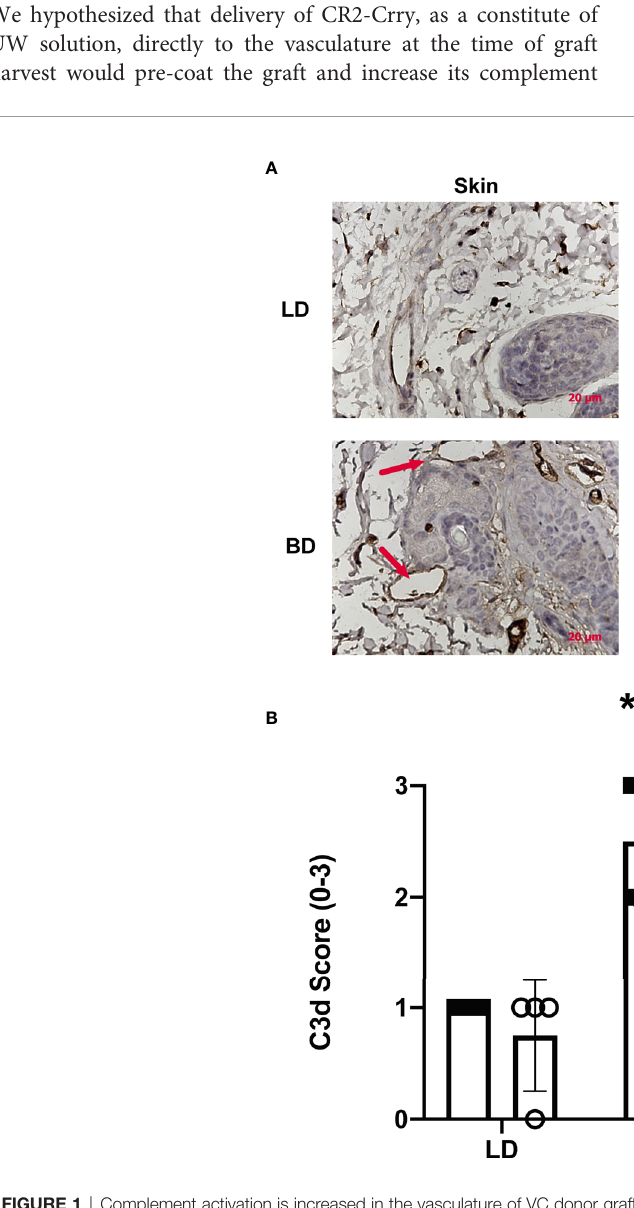
FIGURE 1 | Complement activation is increased in the vasculature of VC donor grafts following brain death. (A) Representative images of C3d deposition assessed by immunohistochemistry in living donors and brain dead donors 3 hrs post BD induction. Note the positive staining for C3d (brown) can be seen within vessels of both the skin and muscle in the VC donor graft. Representative images, (n = 4 for each group). (B) Semi-quantitative histopathological scoring shows increased C3d deposition in in grafts from brain dead donor tissues as compared to grafts from living donors. Pairwise comparison between brain dead donor vs living donor (***p < 0.01, n = 4 in each